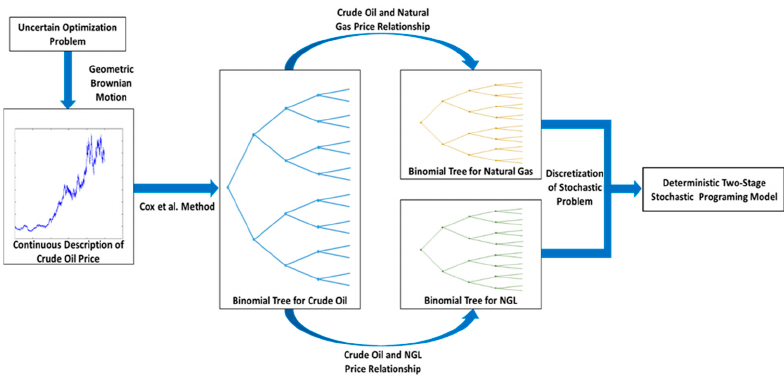
Figure 2. Framework for discretization of stochastic optimization problem.